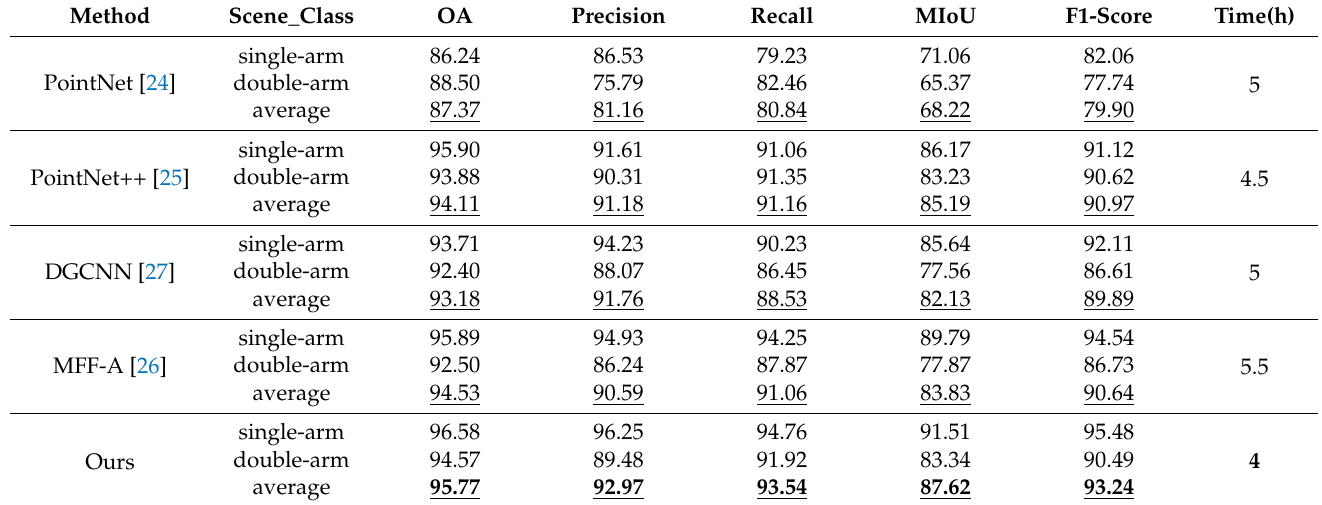
Table 4. Quantitative evaluation of the comparative methods on the OCS point cloud dataset (%). The average is underlined and the best metrics are highlighted in